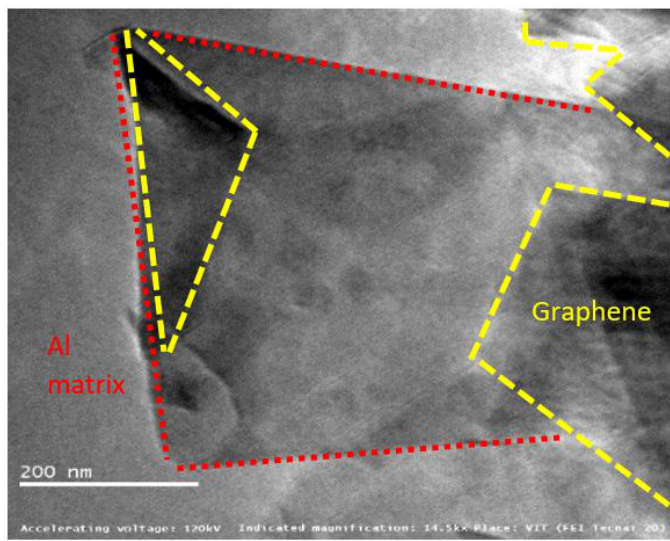
Figure 17. Graphene sheets embedded in AA6061 at 14.5 kX.